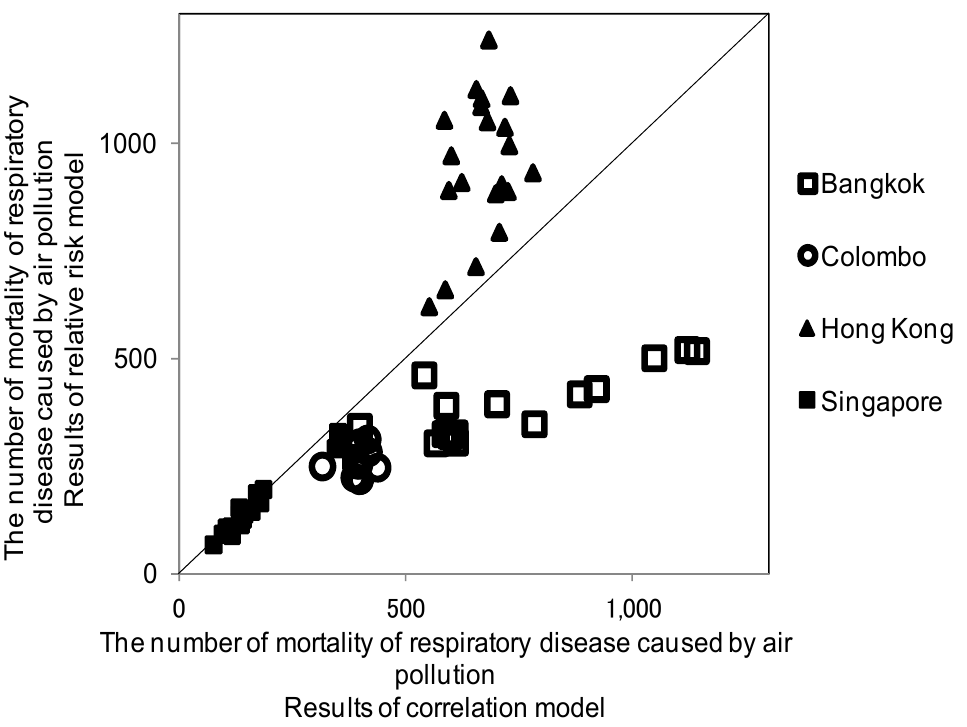
Figure 2. Overall comparison of the results from the two models (Bangkok, Colombo, Hong Kong, and Singapore).